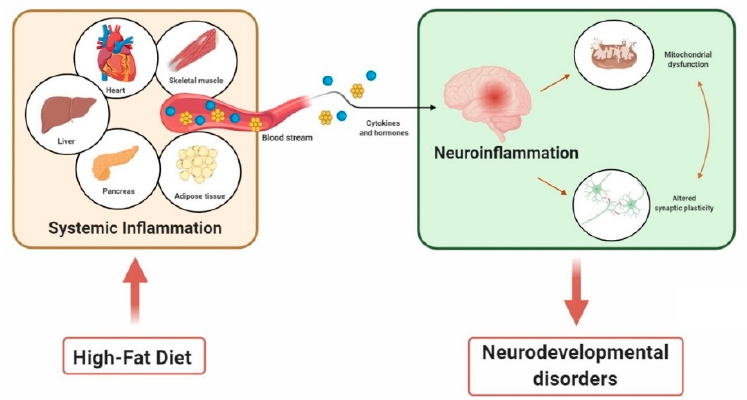
Figure1. Ageneralschemeofhigh-fatdiet(HFD)beinglinkedtoinflammationandneurodevelopmental Figure 1. A general scheme of high-fat diet (HFD) being linked to inflammation and disorders (NDDs). HFD a ff ects several organs, leading to systemic inflammation. Proinflammatory neurodevelopmental disorders (NDDs). HFD affects several organs, leading to systemic cytokines and hormones, which are released in response to the inflammation, induce neuroinflammation, inflammation. Proinflammatory cytokines and hormones, which are released in response to the accompanied by mitochondrial dysfunctions and altered synaptic plasticity in the brain, thus inflammation, induce neuroinflammation, accompanied by mitochondrial dysfunctions and altered contributing to synaptic plasticity in the brain, thus contributing to NDDs.